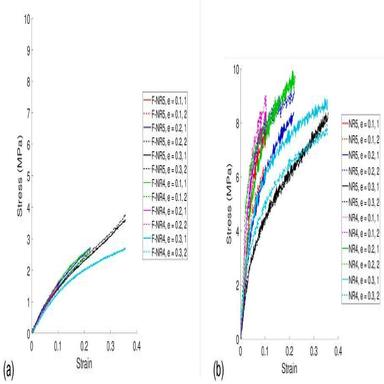
Results of varying strain quasi-static compression experiments at 10− 2 s − 1 for 50% F-NRs at (a) − 40 ◦C and (b) − 50 ◦C.